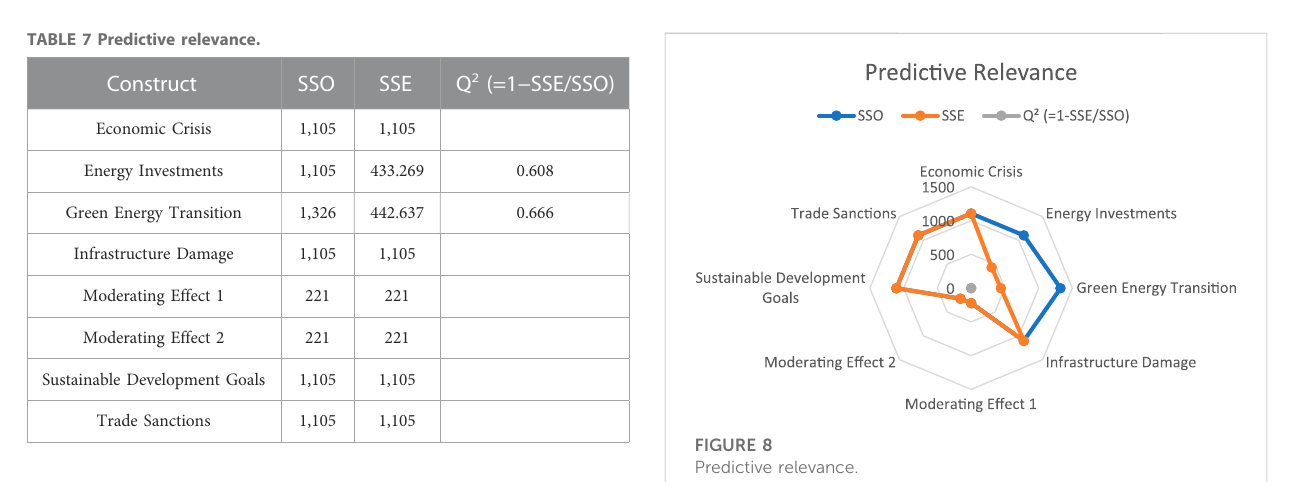
FIGURE 7 Path coef fi cients.